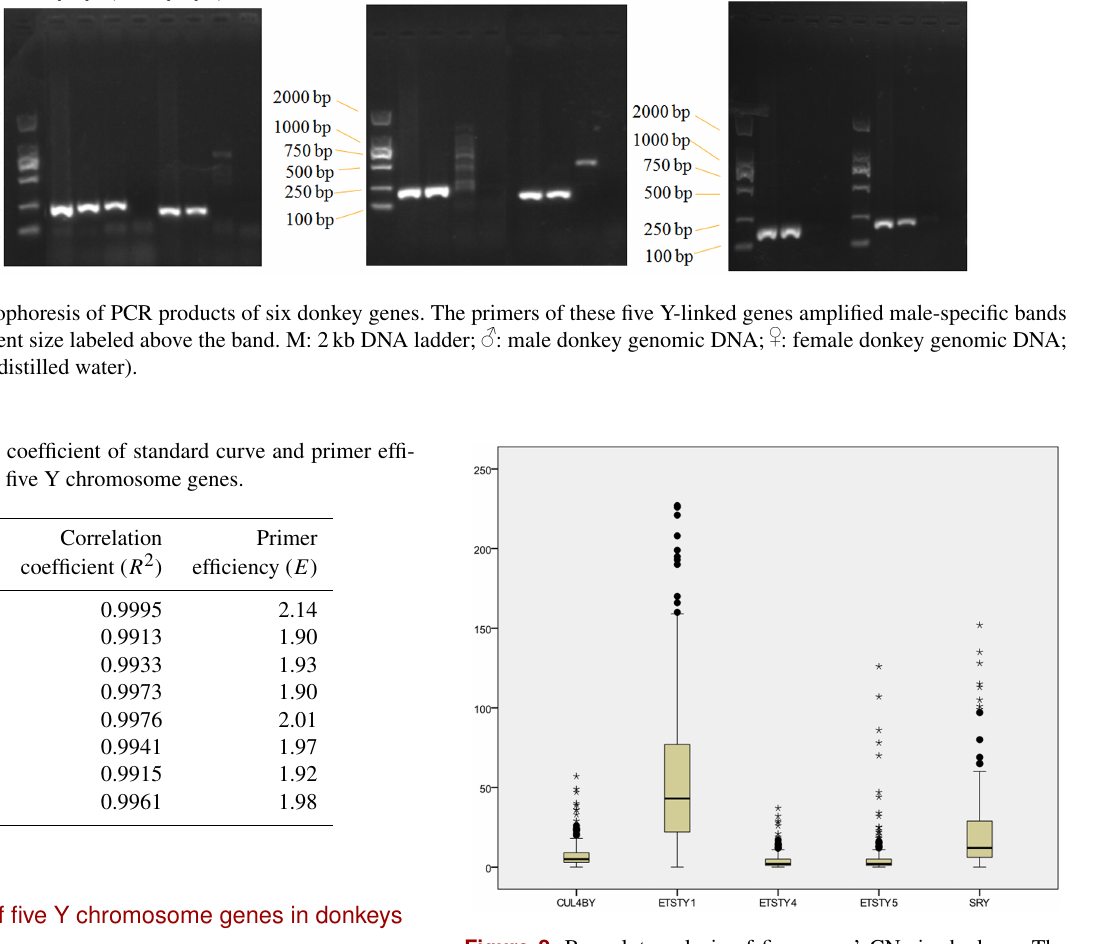
Figure 2. Box plot analysis of five genes’ CNs in donkeys. The outliers are indicated by a solid circle or an asterisk (extremely high CN), which include 10–15 donkeys in all breeds for five Y chromo- some